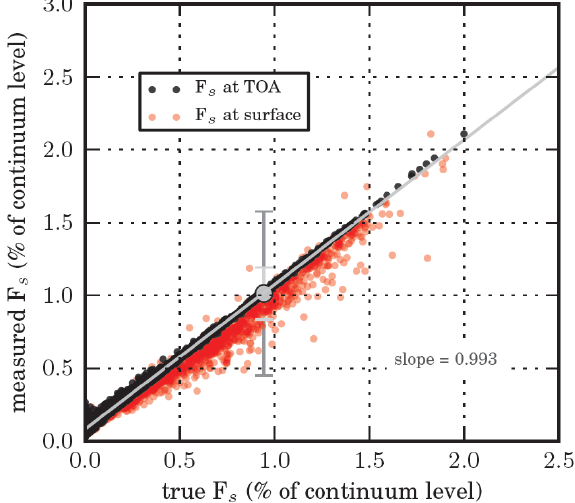
Fig. 11. Retrievals of F s in a scattering atmosphere using the Fraun- hofer line method (Frankenberg et al., 2011a). Points are for true F s at TOA vs. retrieved F s (black) and true F s at the surface vs. retrieved F s (red). Small deviations from the 1.0 slope can be ex- plained by small differences in the spectral shift and squeeze as well as the assumed constancy of F s (Frankenberg et al., 2011a). Error-bars indicate a typical 1- σ precision error for a GOSAT spe- cific retrieval. Dark gray indicates the single measurement noise and light gray the standard error in an average of 10 soundings.